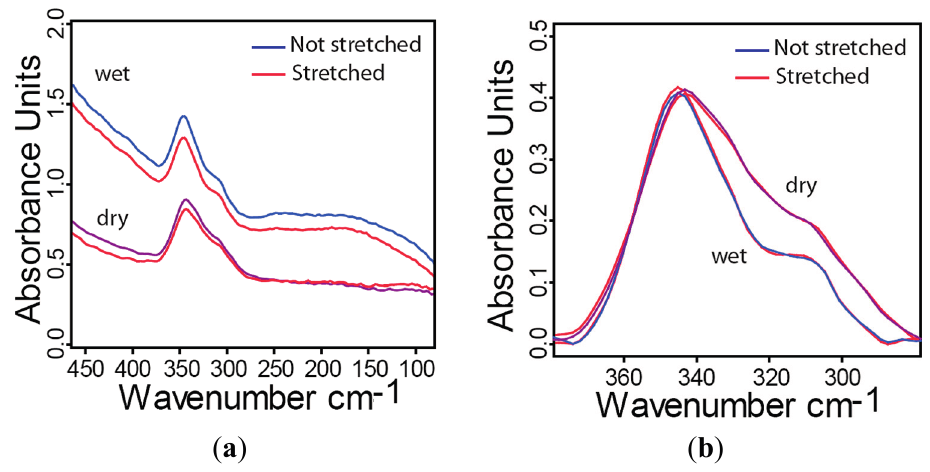
Figure 6. Far-IR spectra of collagen from fully demineralized bovine fibrolamellar bone. ( a ) Comparison between the spectra of stretched (8%–10% strain, red) to unstretched and under wet and dry conditions; ( b ) Same spectra but baseline corrected and “zoomed in” to focus on wavenumbers between 380 and 280 cm − 1 . Absorbance peaks are normalized to their